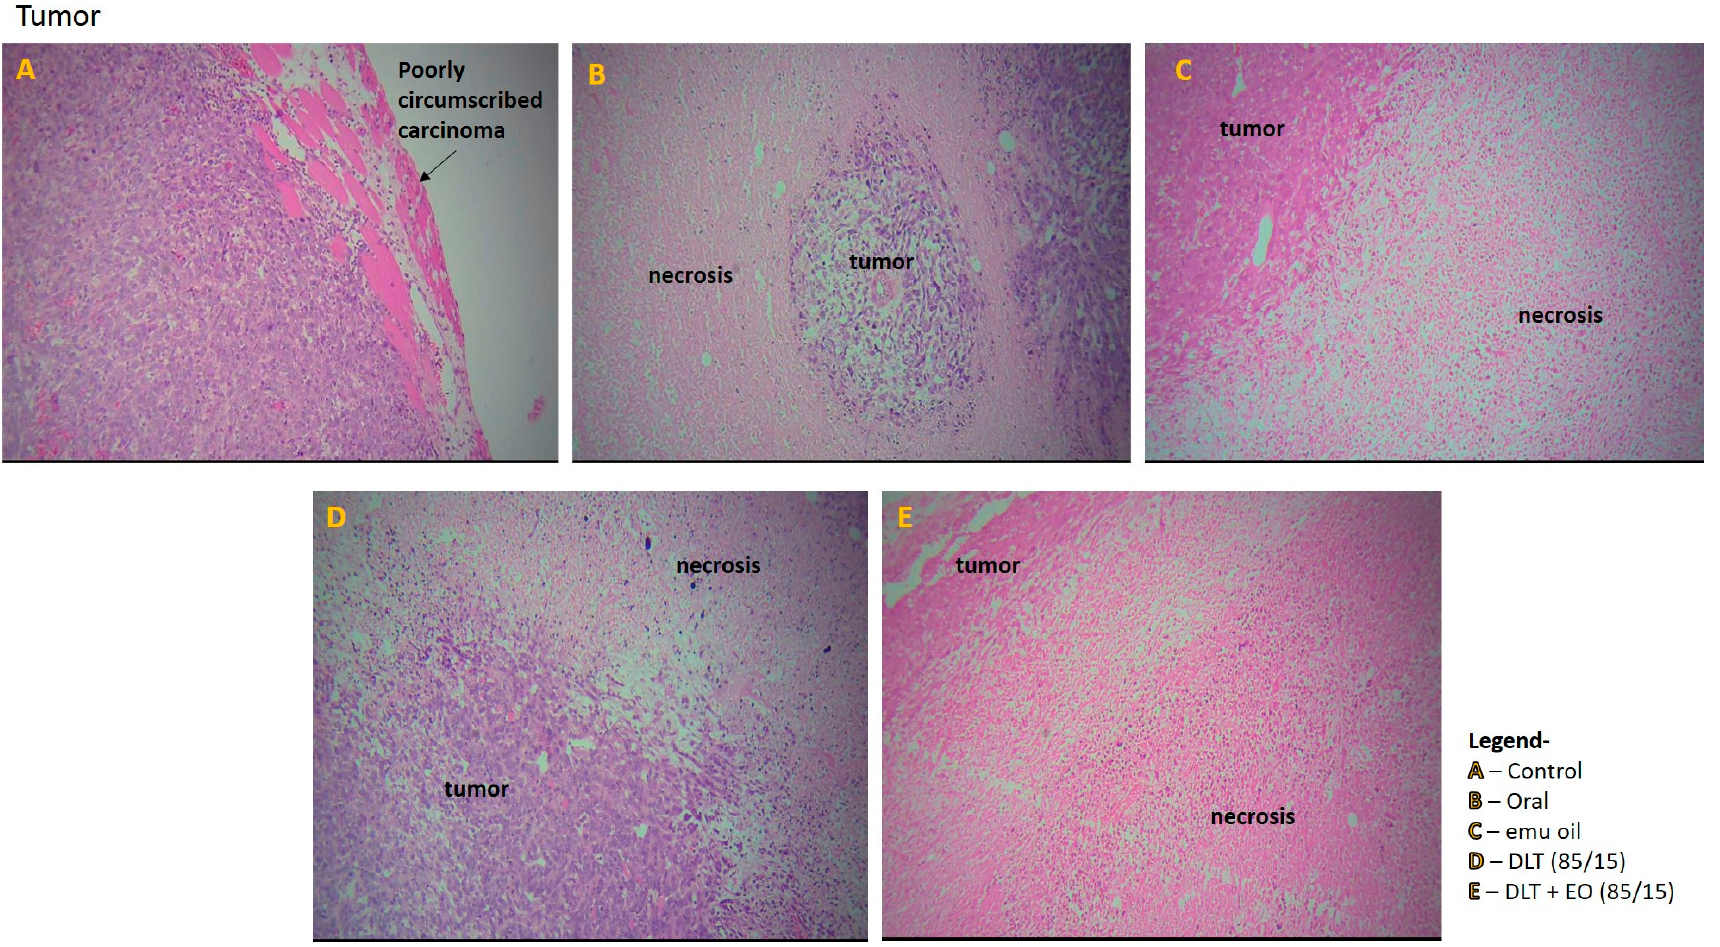
Figure 6. Photomicrographs from the tumor of the ( A ): control (untreated), ( B ): orally treated (TAMX), ( C ): topically treated with emu oil (without the presence of drugs), formulations; ( D ): DLT (85/15) and ( E ): DLT + EO (85/15), at day 18 post treatment. H&E magnification 100×. Note: DLT—deformable liposomes, DLT + EO—deformable liposomes with emu oil.